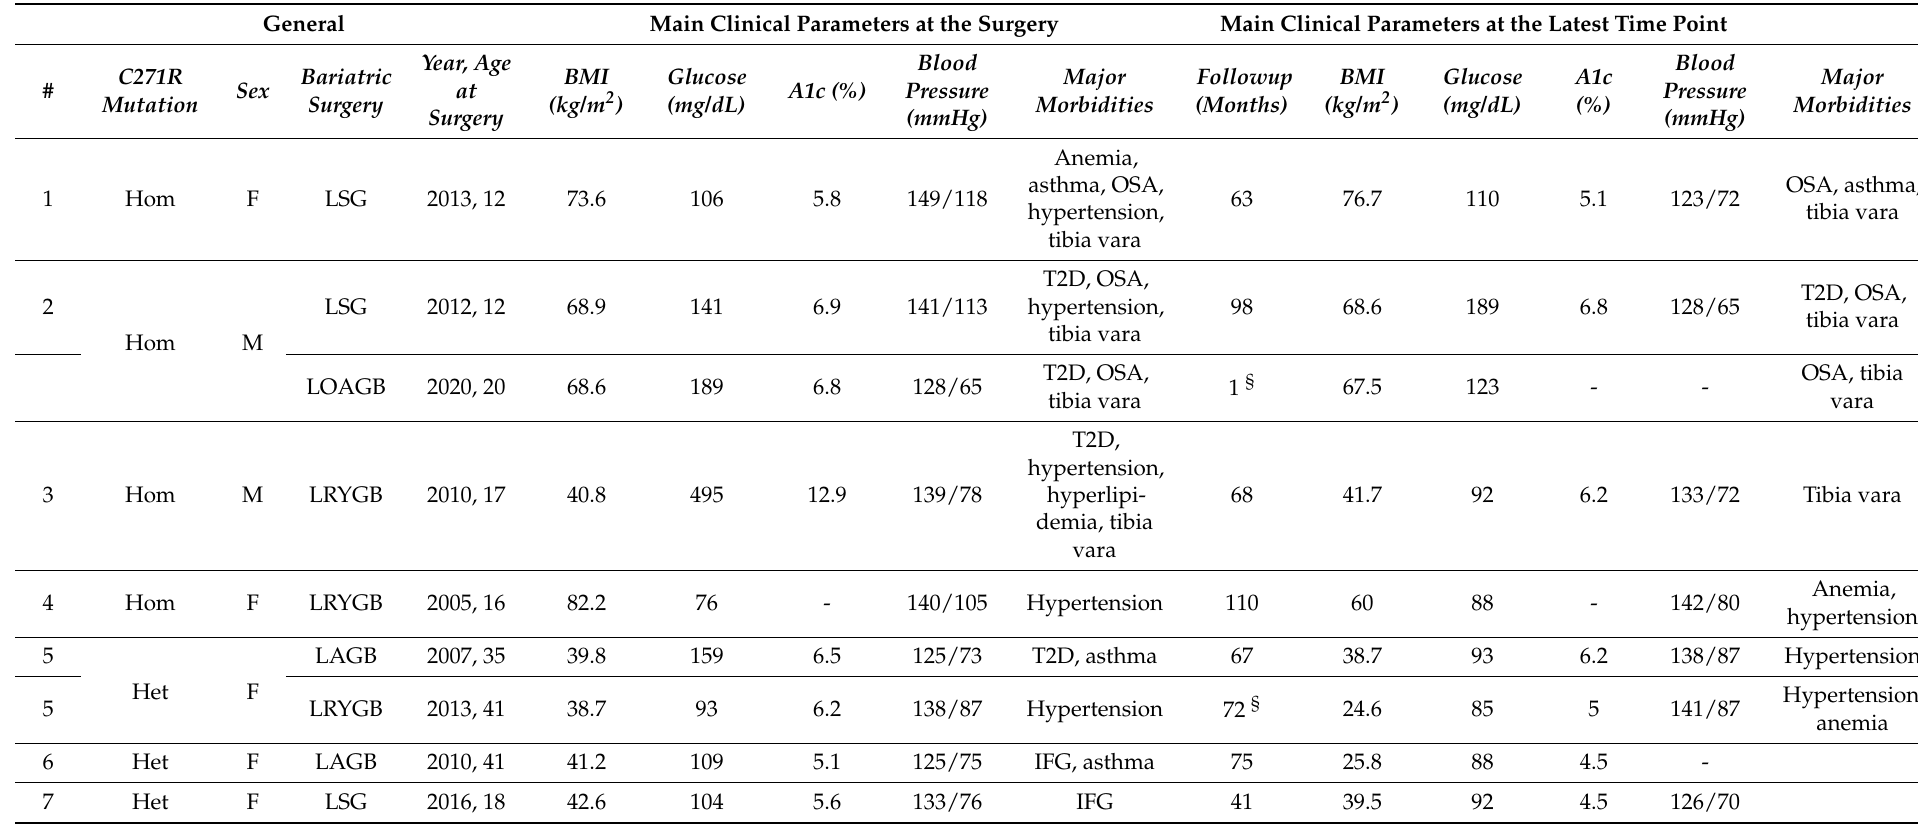
Table 2. Summary of cases. The four adolescent patients homozygous for the C271R mutation in MC4R are in the top rows (Hom), and the three heterozygous patients are below (Het). § Values are follow-up months since revisional surgery. LAGB: laparoscopic adjustable gastric banding; LSG: laparoscopic sleeve gastrectomy; LRYGB: laparoscopic Roux-en-Y gastric bypass; LOAGB: laparoscopic one anastomosis gastric bypass; BMI: body mass index; A1c: glycated hemoglobin; OSA: obstructive sleep apnea; T2D: type 2 diabetes mellitus; IFG: impaired fasting glucose. Glucose levels reflect fasting plasma glucose. Main Clinical Parameters at the Surgery Main Clinical Parameters at the Latest Time